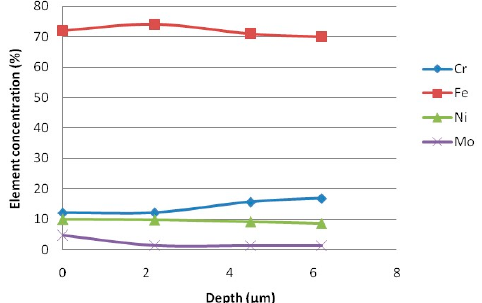
Figure 9. EDX chemical analysis of SS 316L sample after 100 h heating.